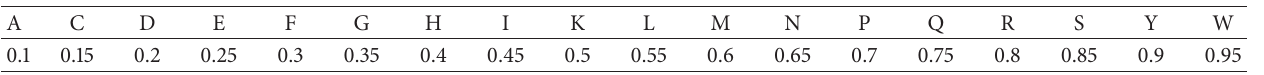
Table 2: Conversion of the 16-amino acid alphabet to numeric form between 0 to 1 for input to perceptrons. Y and W (two extra characters) represent the gaps introduced during alignment (see main